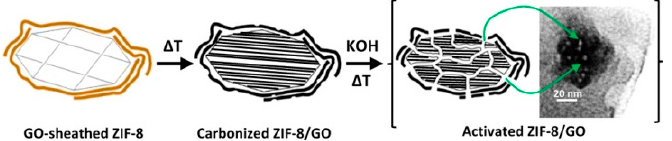
Figure 8. Mesopore generation process to the activated ZIF-8/GO composite via “Nanopore Lithography” approach